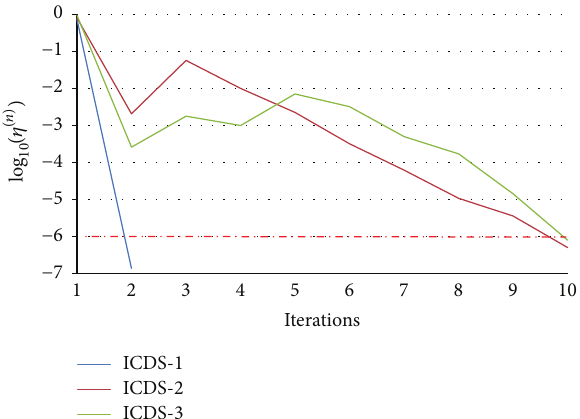
Figure 5: Convergence trend of relaxation algorithm under three ICDS.